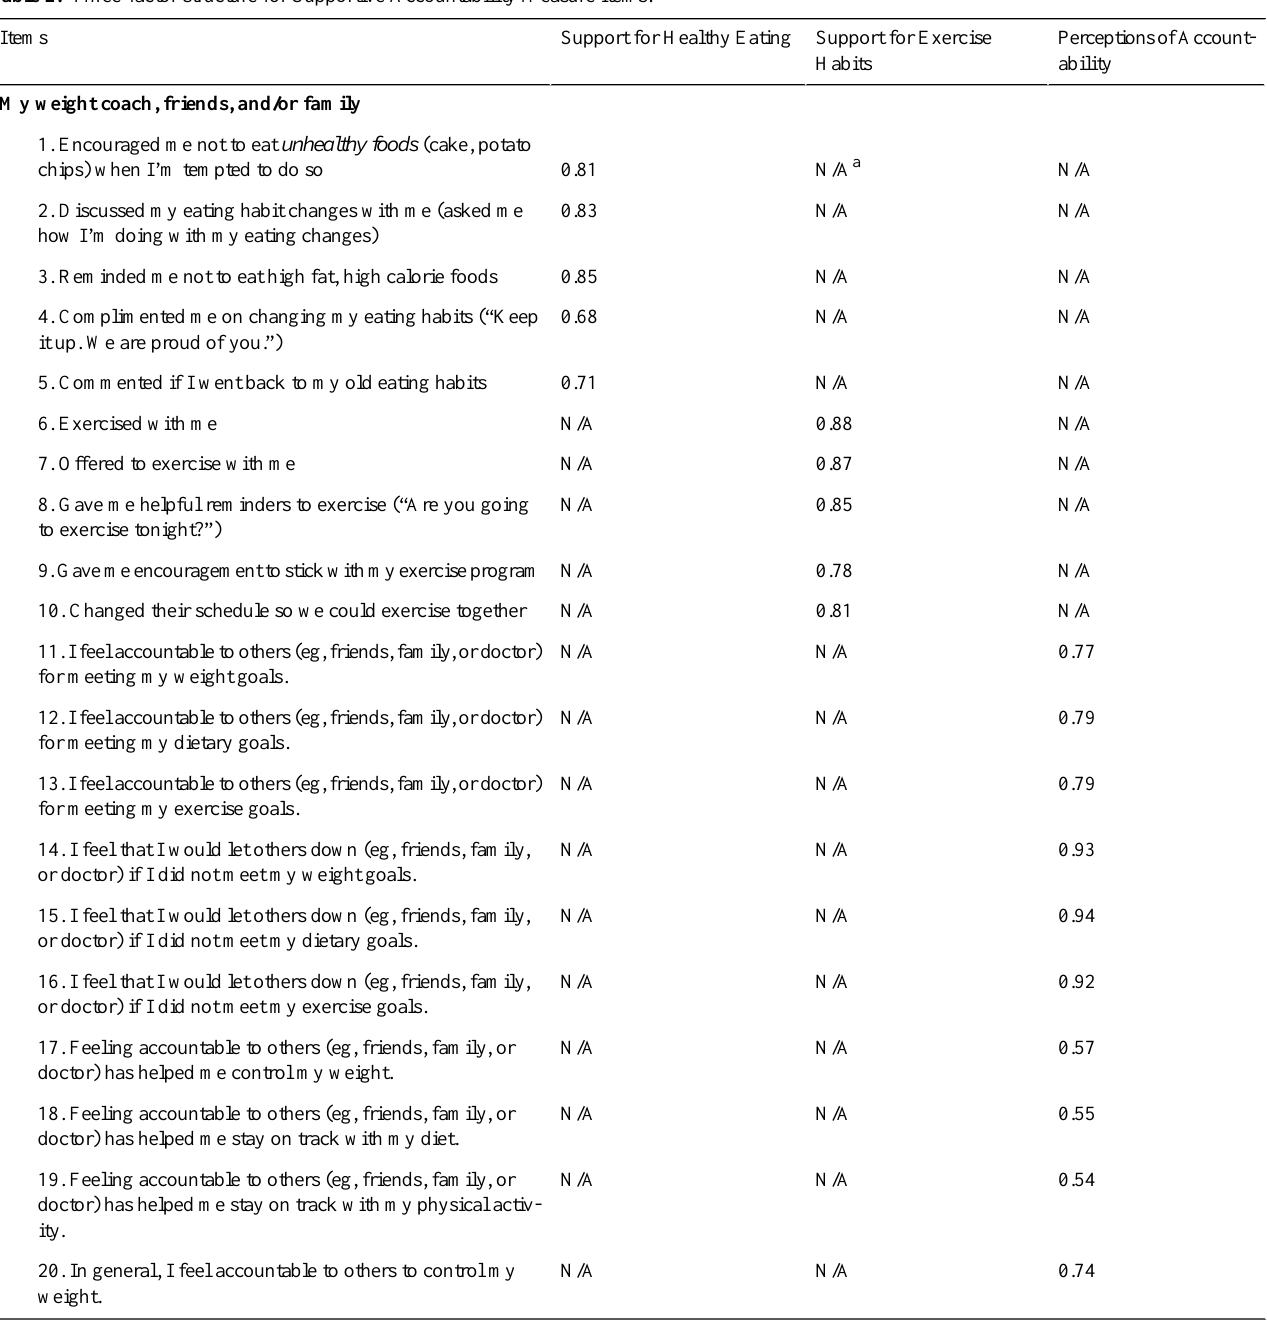
Perceptions of Account- abilitySupport for Exercise HabitsSupport for Healthy EatingItems